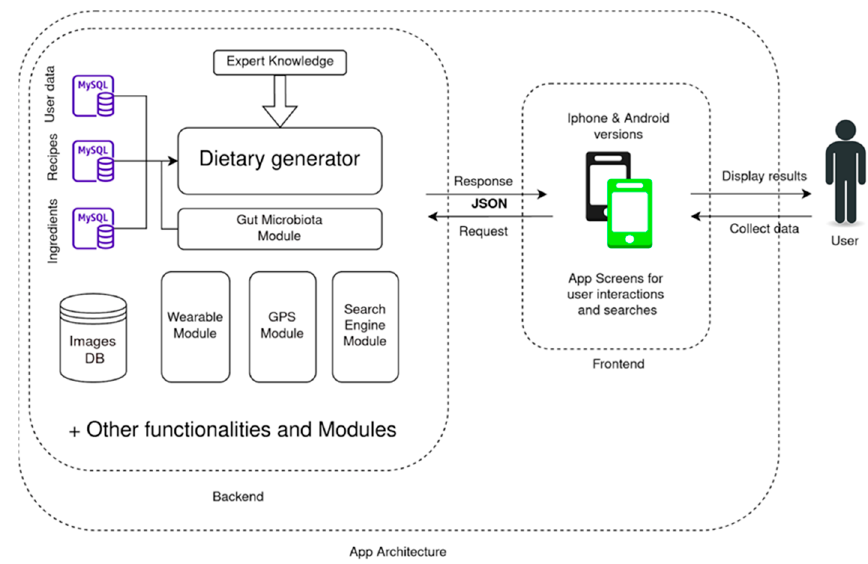
Figure 1. Overview of the S4H APP design and architecture.